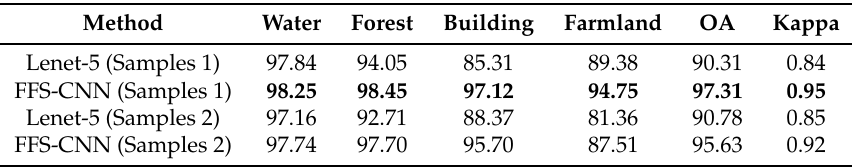
Table 5. The classification accuracies of GF-3 Wuhan (%).